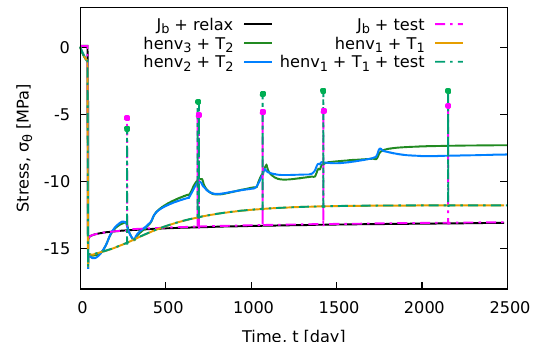
Figure 8. Evolution of hoop stress in the center of the wall - pressure